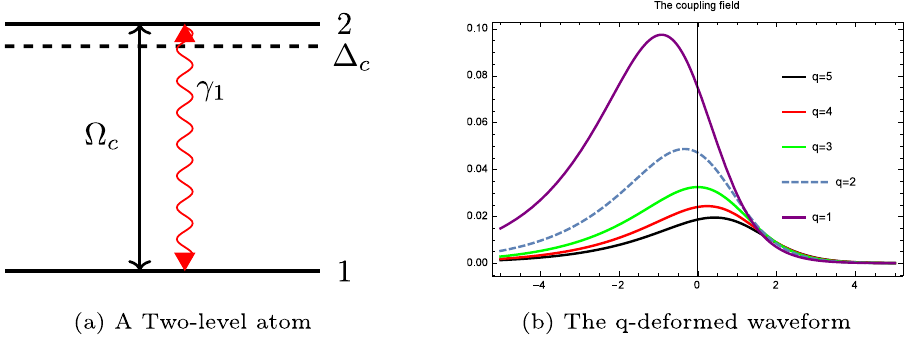
Figure 1. ( a ) A two-level atom excited by a strong field with Rabi-frequency (cid:31) c , ( b ) The q-deformed laser shape for various